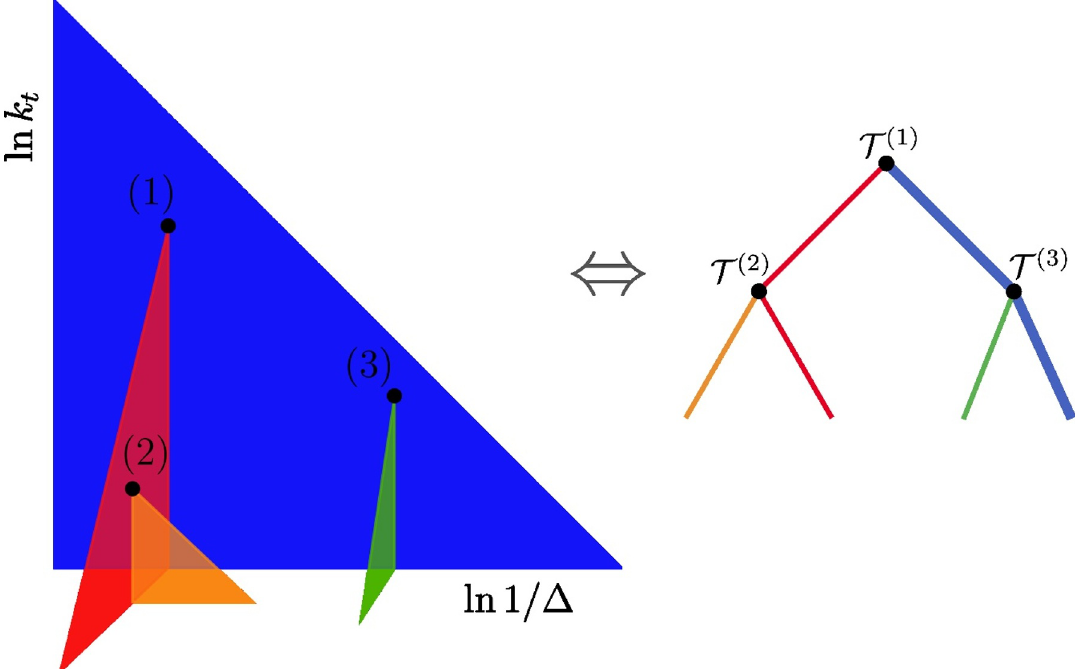
Figure 1 . The Lund plane representation of a jet (left) where each emission is positioned according to its ∆ and k coordinates, and the corresponding mapping to a binary Lund tree of tuples (right). t The thick blue line represents the primary sequence of tuples L